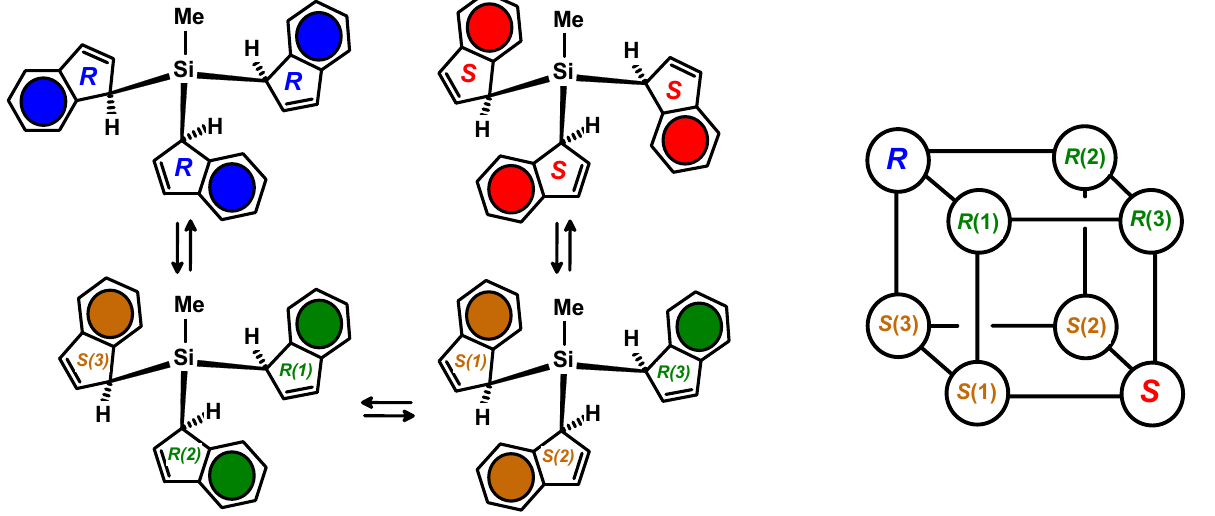
Scheme 6. ( Left ) Interconversions of the eight different indenyl ring environments of tris(indenyl)methylsilane. The configurational inversion of a single indenyl ring requires two [1,5]-suprafacial sigmatropic shifts [9]. ( Right ) The cube representing exchange between the eight different ring environments in 11 .